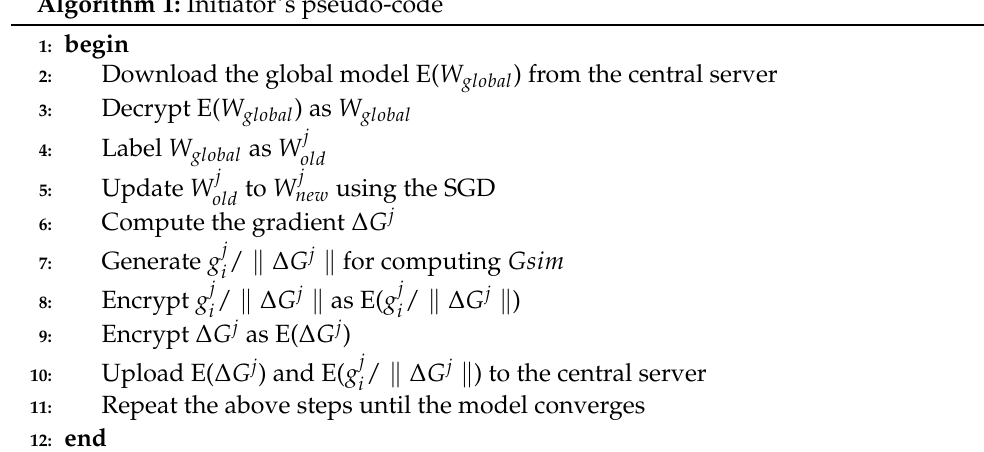
Algorithm 1: Initiator’s